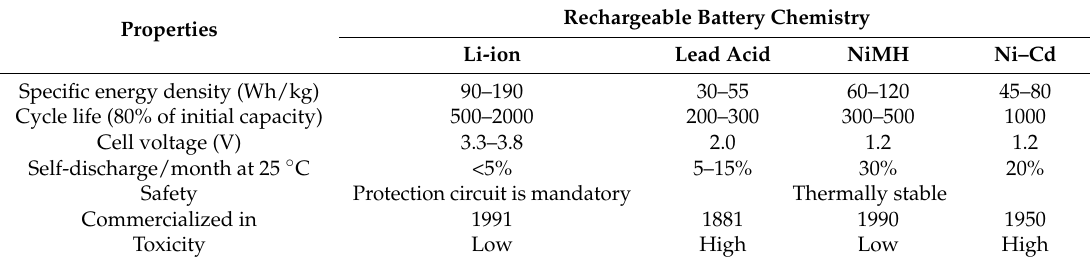
Table 1. Comparison of different battery chemistries [5,6].